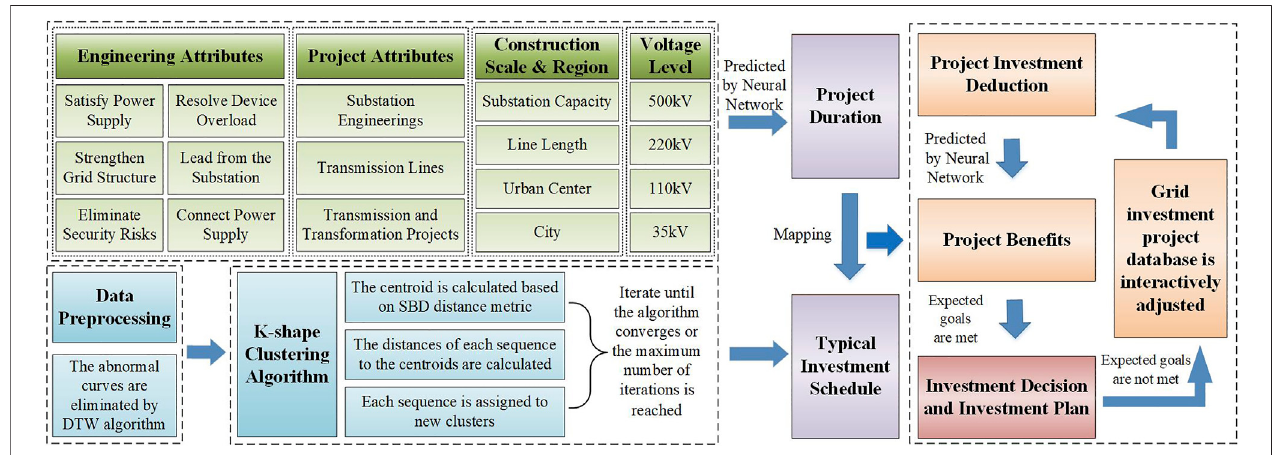
FIGURE 1 | Proposed deduction prediction framework of power grid infrastructure investment and